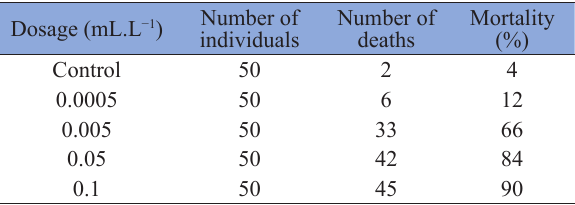
Table 1: Mortality of susceptible reference line treated with Spirodiclofen acaricide (bioassay to find biological window).